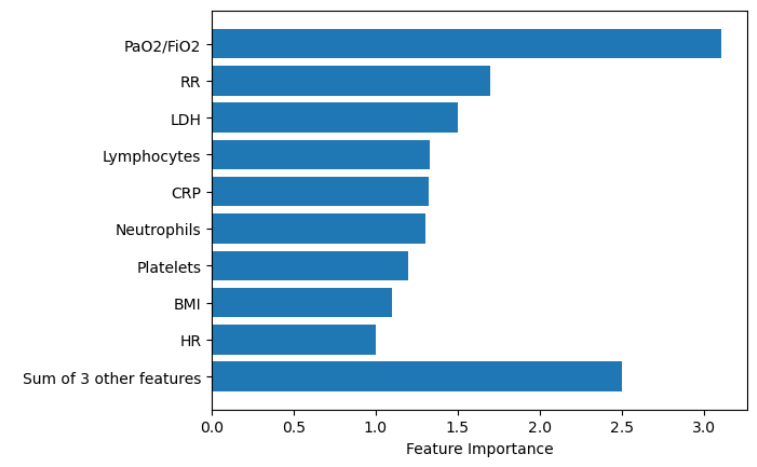
Figure 2. Features importance using XGBoost and SHAP library [30].